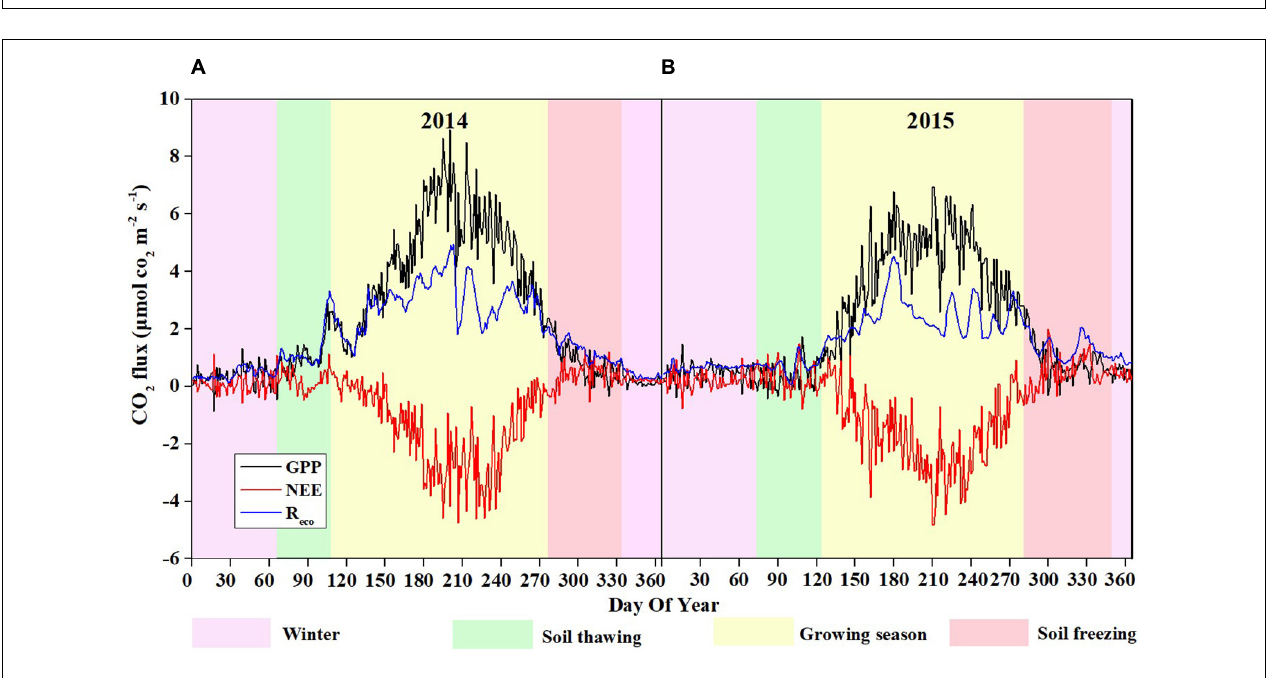
FIGURE 5 | Seasonal patterns of daily NEE, GPP, and R eco in 2014 (A) and 2015 (B) .